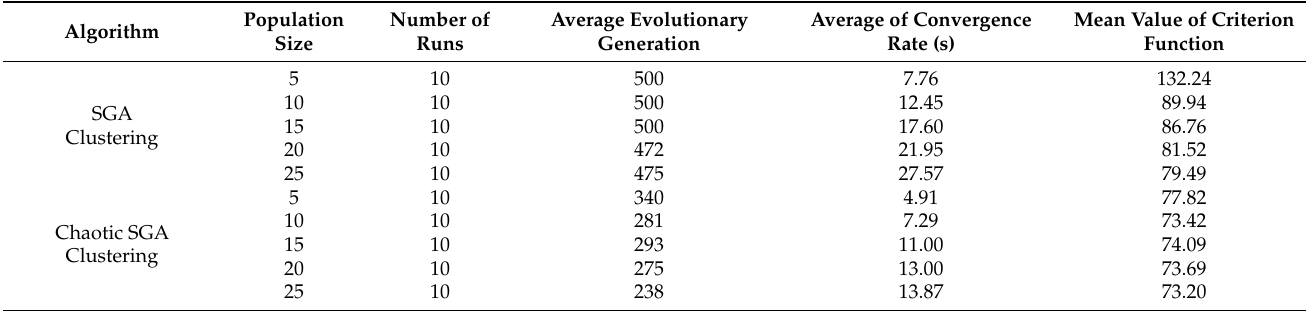
Table 3. Performance evaluation of SGA clustering and chaotic SGA clustering under two beam control modes (data from highway scene